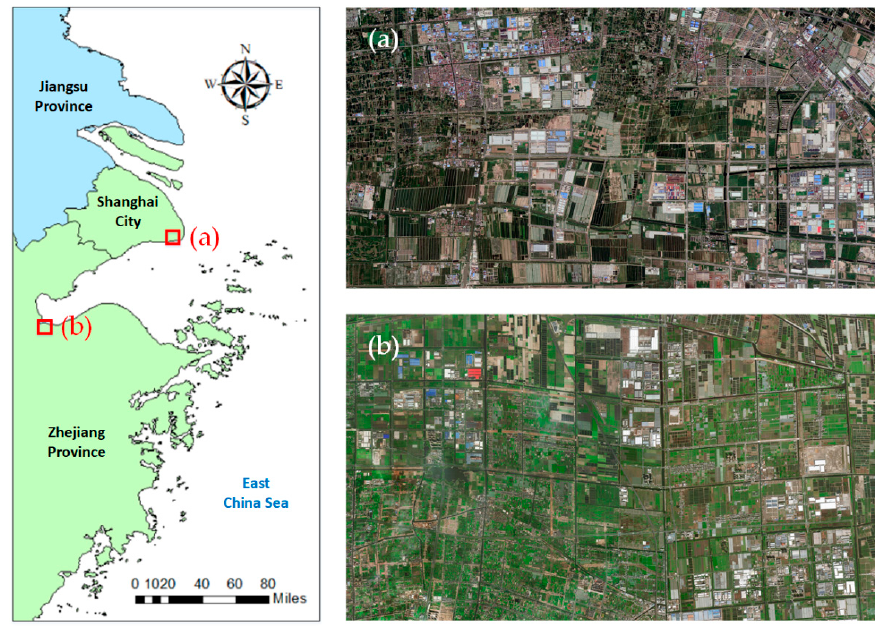
Figure 4. Overview of coastal remote sensing datasets: ( a ) Shanghai dataset, ( b ) Zhejiang dataset.